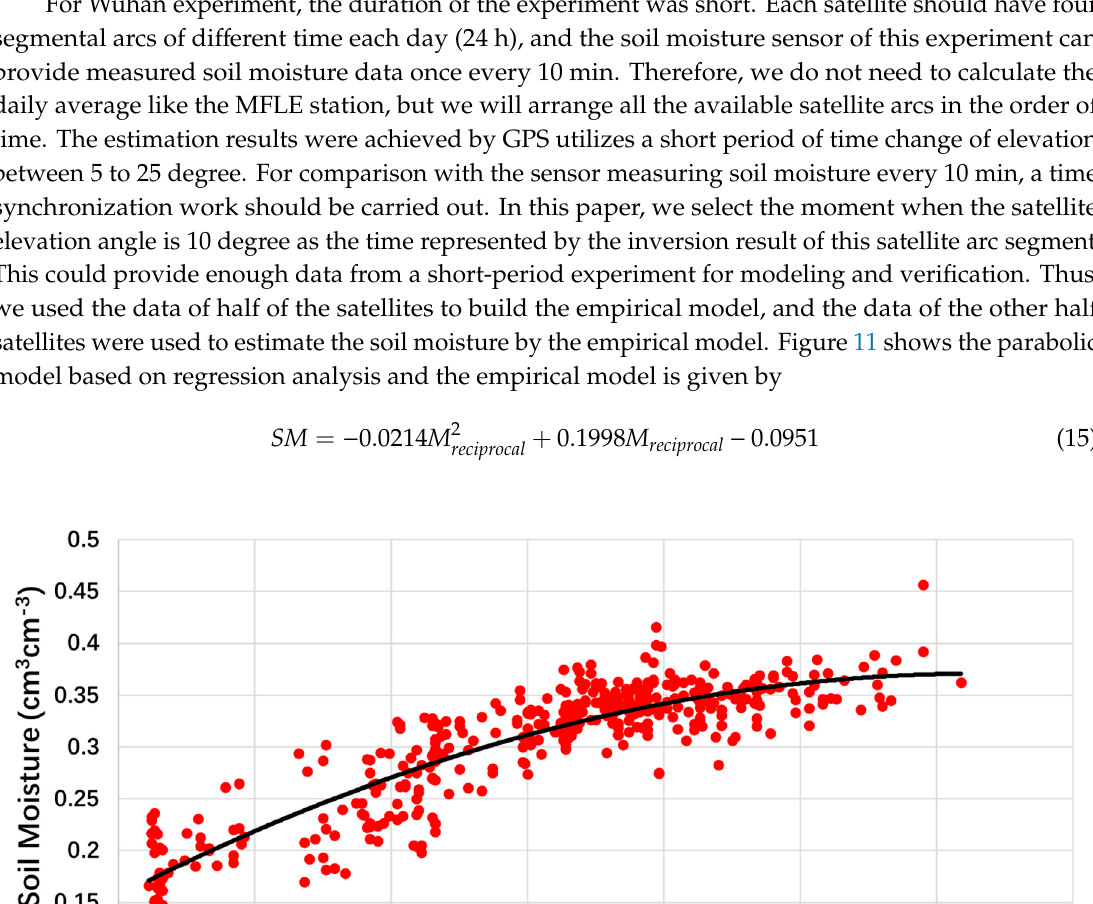
Figure 10. Equipment and surrounding environment ( left ), soil moisture sensor ( right ).